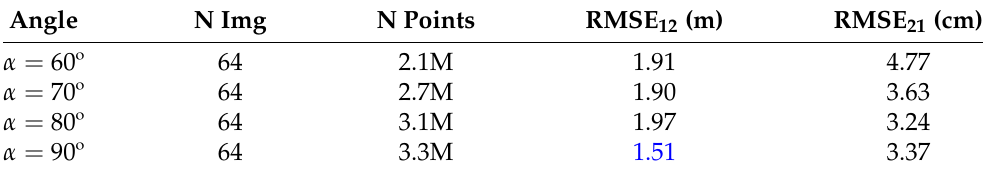
Table 2. Quality metrics for different camera angles: N Img (number of images), N Points (number of points) and RMSE (Root Mean Square Error). Blue values represent the best